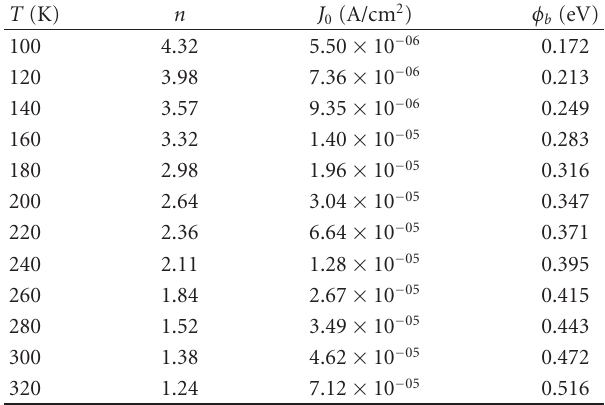
Table 1: The T , n , J 0 , and φ B values for the investigated device structure of Figure 3.